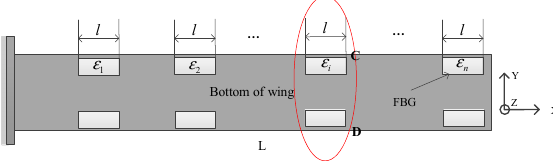
Figure 4. Schematic diagram of deformation measurement of FBG sensor on the lower surface.